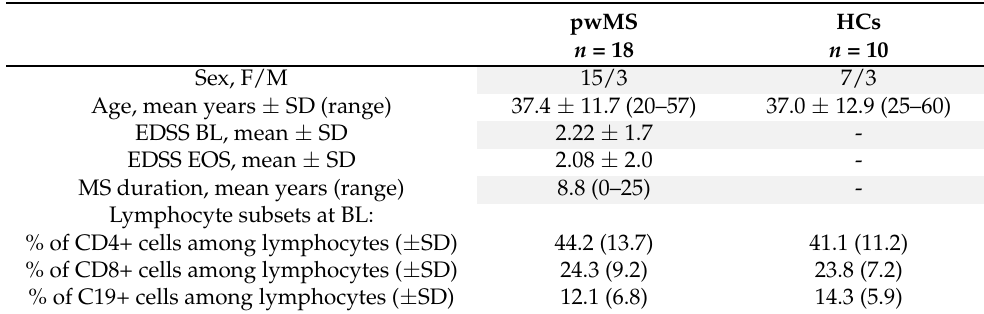
Table 1. Demographics and baseline lymphocyte subsets of the study